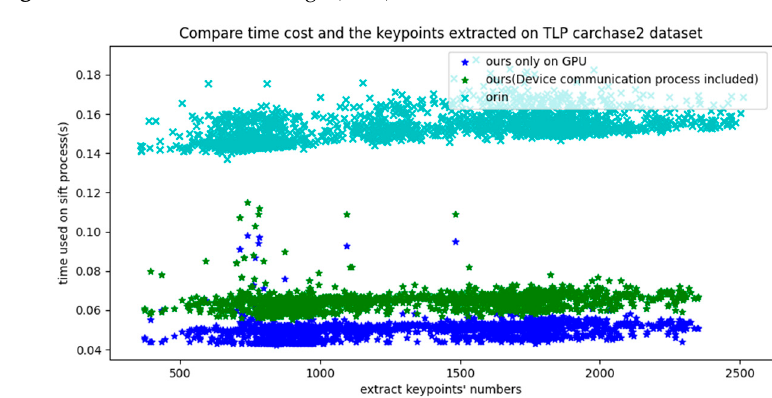
Figure 9. Time Cost of each stage (ours).